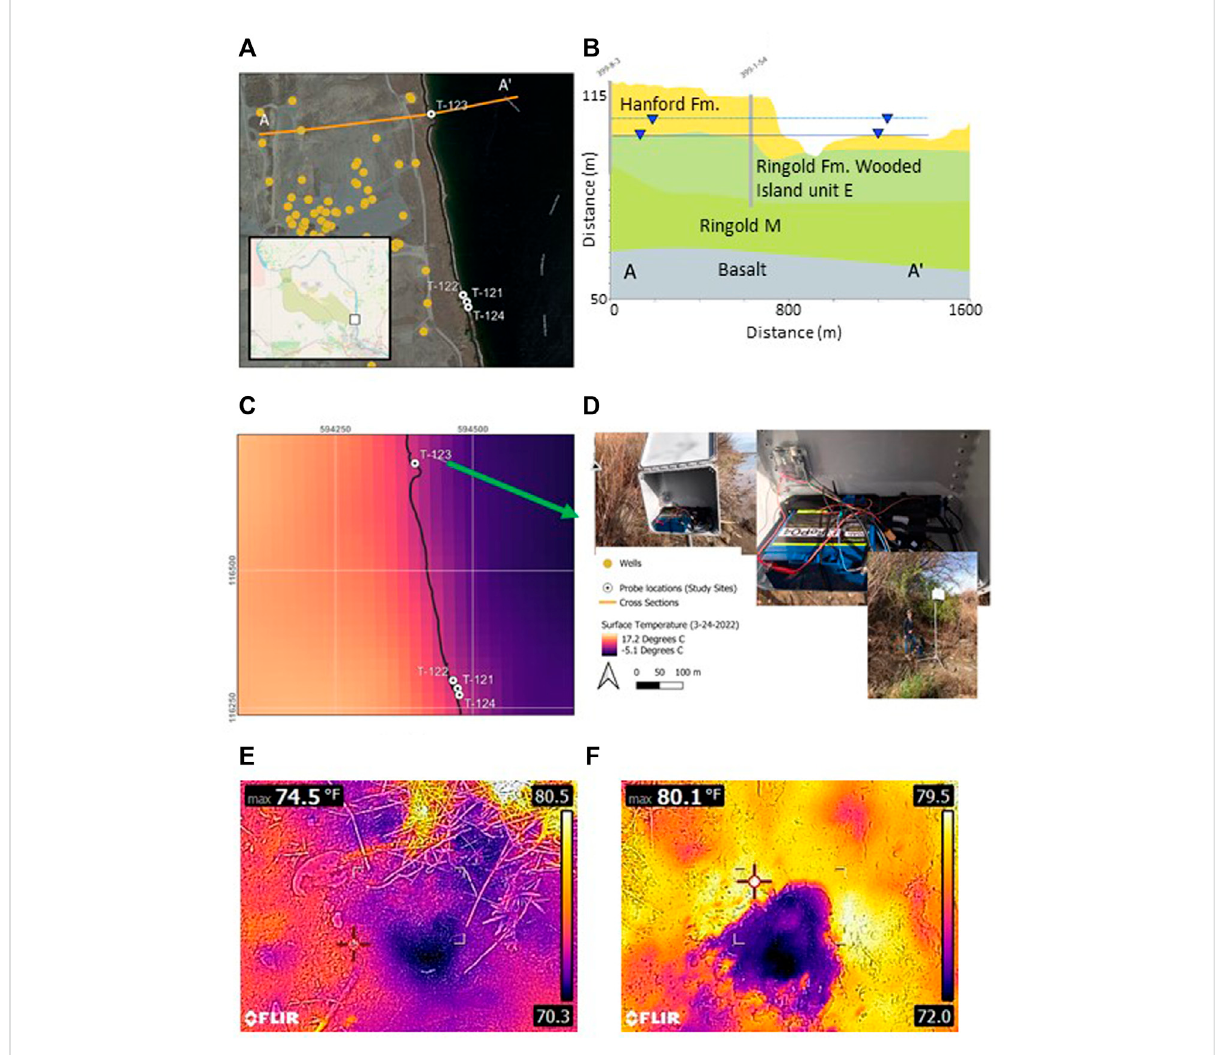
FIGURE 1 (A) Study site and location of probes, highlighting T-123, wells (yellow circles), and cross-sectiontransect; (B) cross section along transect A-A ′ in (A) , (C) ECOSTRESS thermalimagefrom6:28p.m.localtime3/24/2022; (D) thermalcamera setupforautomated monitoring; (E) TIRimageofthe watersurfacecollectedinshallow(~6 cm)surfacewaterusingtheFLIRE8-XTwithin5feetofT-123on9/12/2022;and (F) TIRimagecollectedofthe SWI in the absence of surface water using the FLIR E8-XT within 5 feet of T-123 on 9/12/2022. In (E) and (F) , focused seeps appear as cold anomalies, and the fi eld of view is approximately 1 m in the x